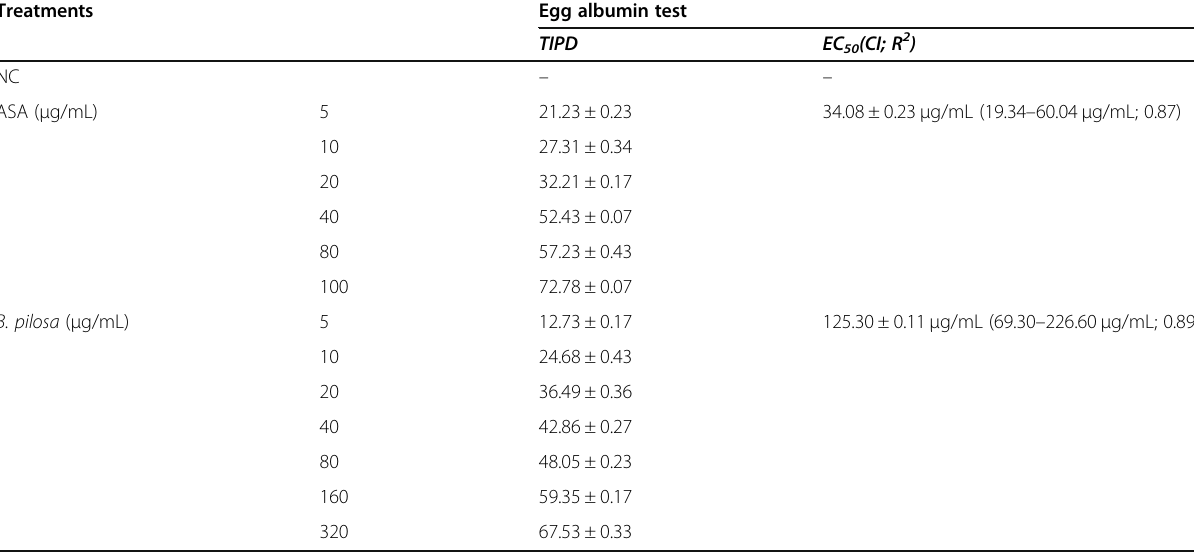
Table 2 Total inhibition of protein denaturation by the B. pilosa ethanol extract and the controls Treatments